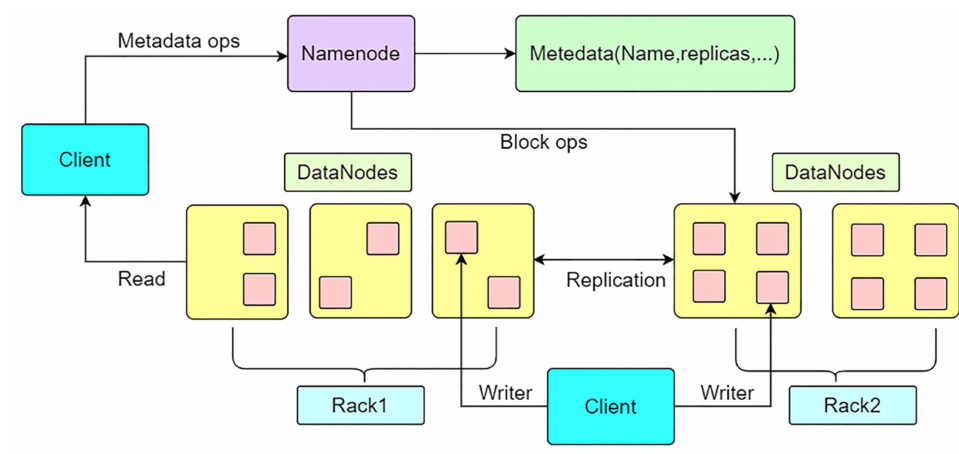
Figure 3. Hadoop Distributed File System (HDFS) framework and processing